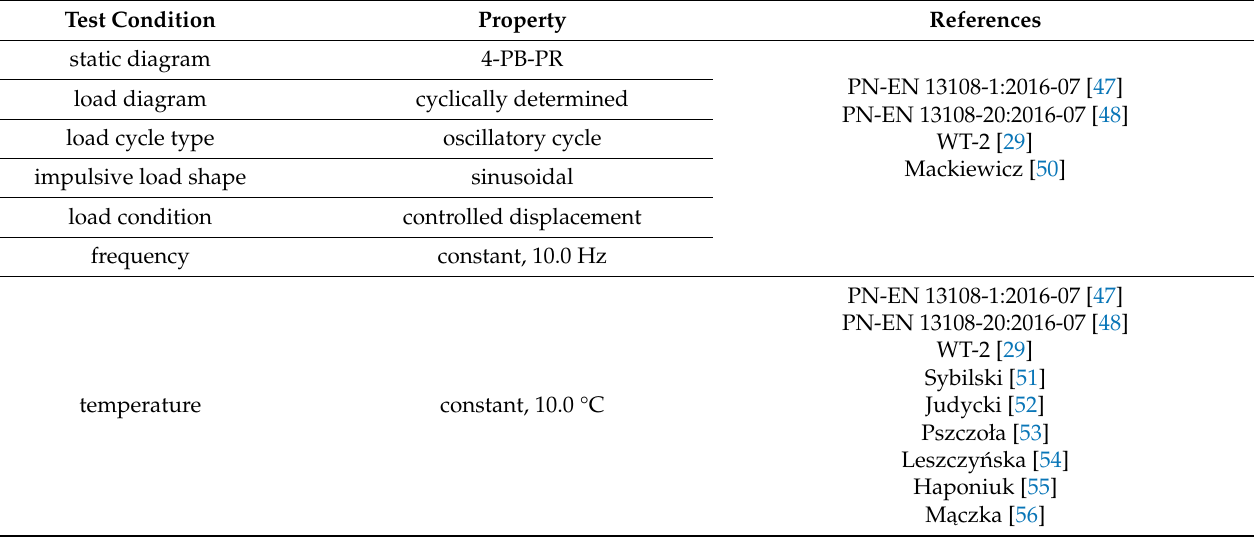
Table 2. General stiffness test conditions.